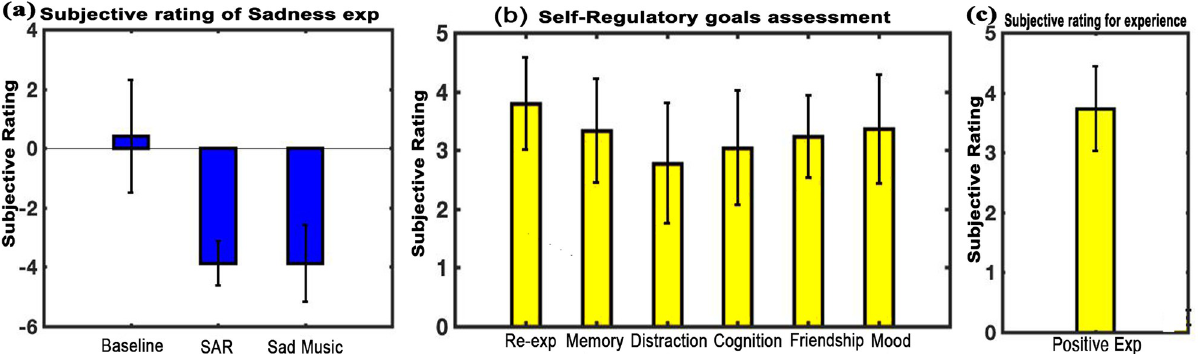
Fig 5. Subjective assessment. (a) Illustrates the mean subjective rating of experience across the three conditions of baseline, SAR, and sad music listening. (b) Illustrates the subjective rating for Self-Regulatory goal upon music listening (c) Illustrates the mean subjective assessment for sad music. Results show a positive experience of listening to music. (error bars = 1